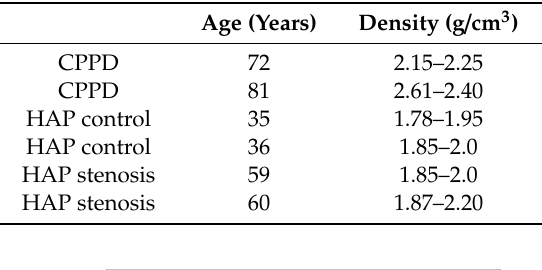
Table 1. The range of density ( ρ ) of calcium pyrophosphate dehydrate (CPPD) hydroxyapatite-like mineral (HAP) grains with a radius of a = (0.02–0.1) cm from control and stenosis groups of patients.